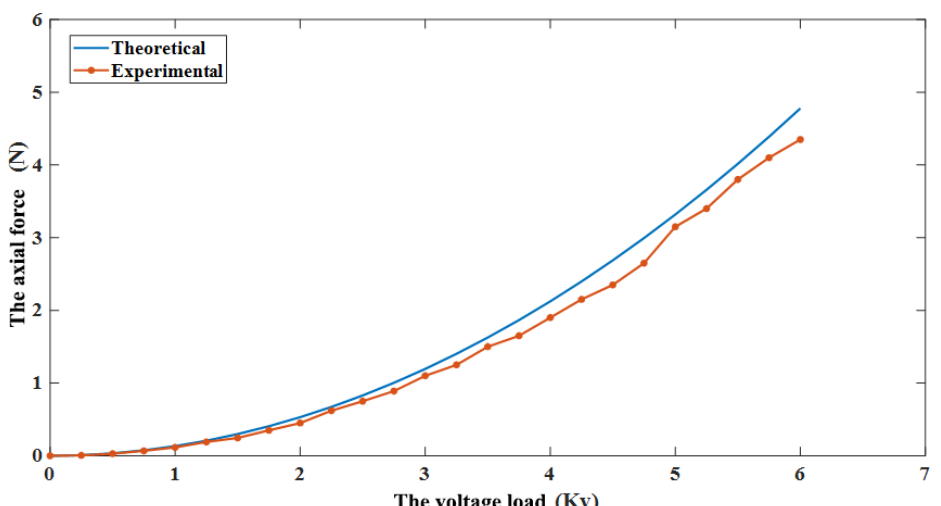
Figure 11. The result of the isometric